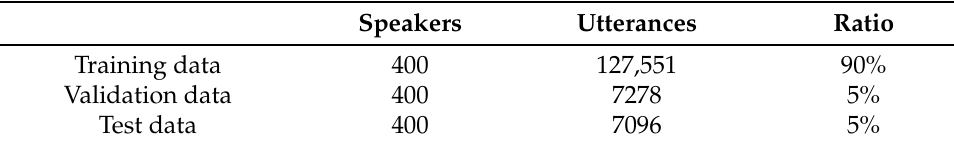
Table 1. The usage of the Aishell-1 dataset in experiments. Speakers Utterances Ratio Training data 400 127,551 90% Validation data 400 7278 5% Test data 400 7096